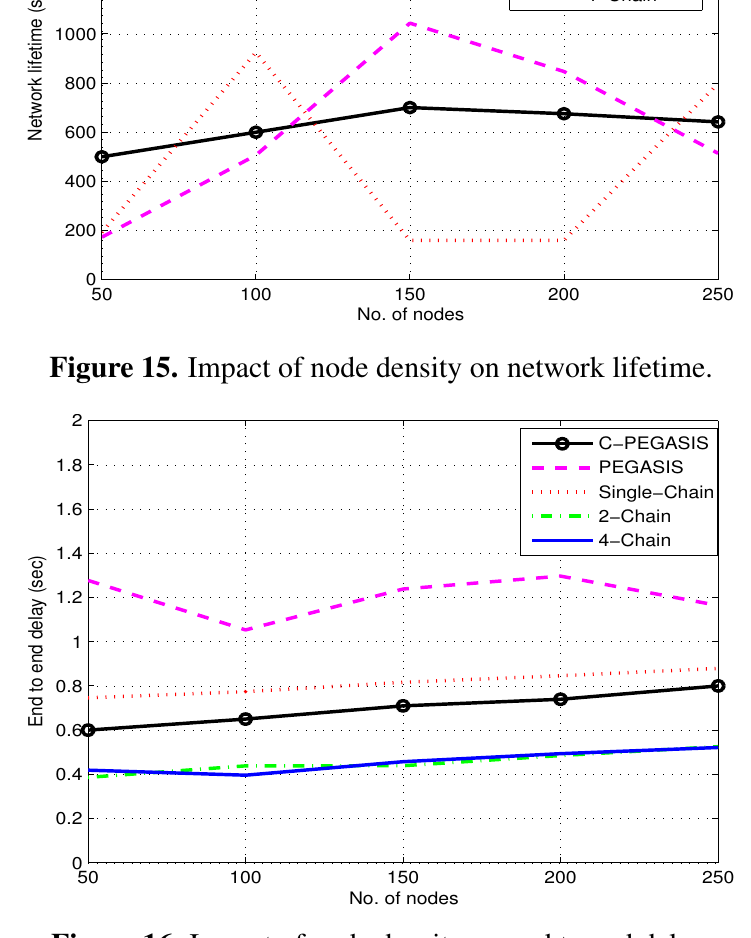
Figure 16. Impact of node density on end to end